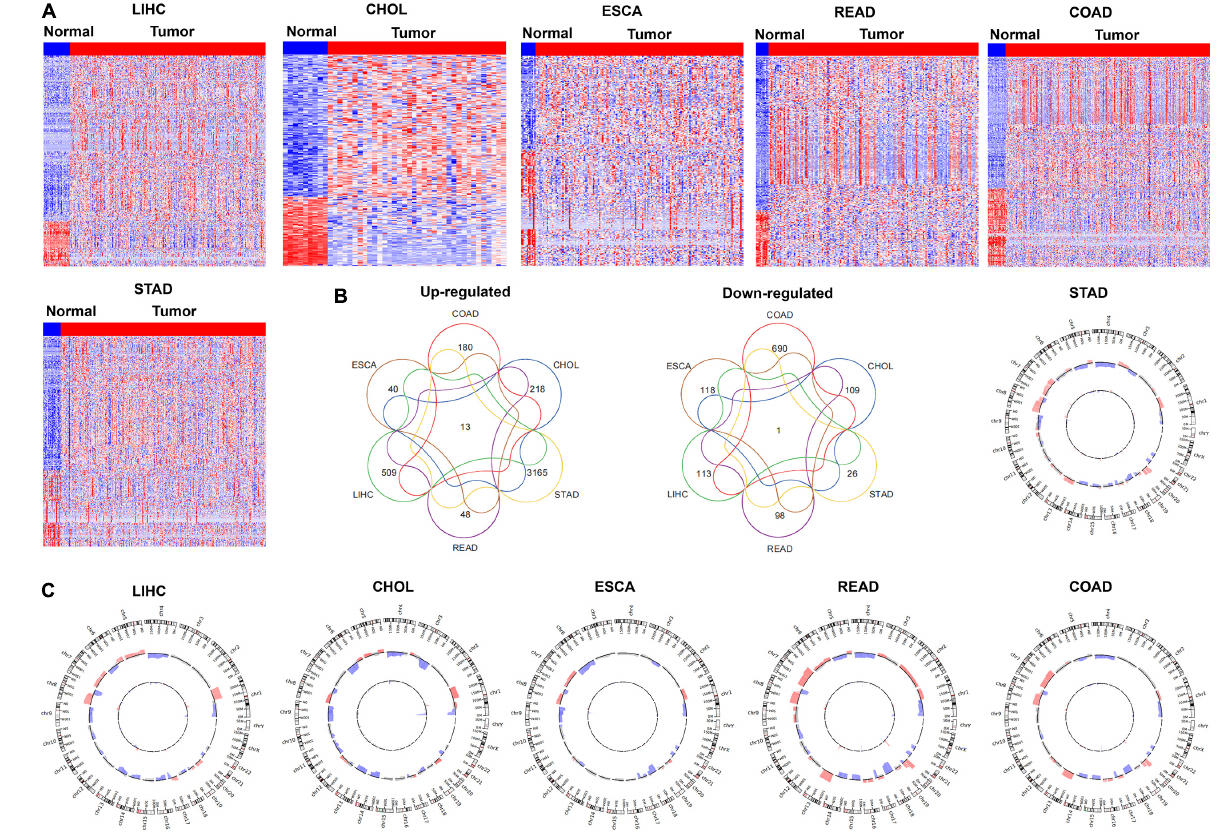
Frontiers in Cell and Developmental Biology |